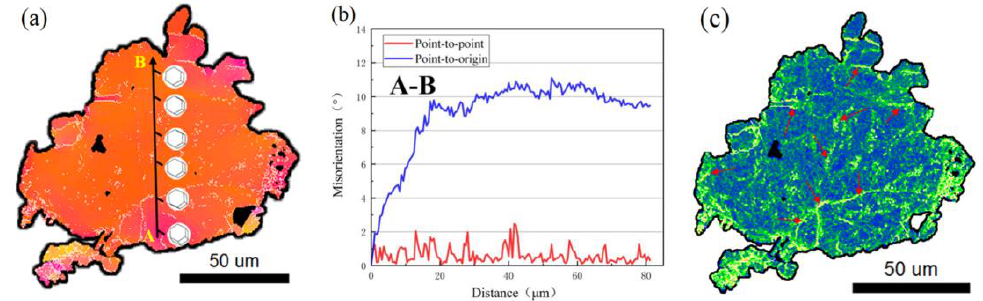
Figure 8. The unDRXed grain G1 in region 5 of the RBEed sample, ( a ) IPF map, ( b ) line profile of the orientation angle along the AB arrow depicted in ( a ), ( c ) KAM map of G1.